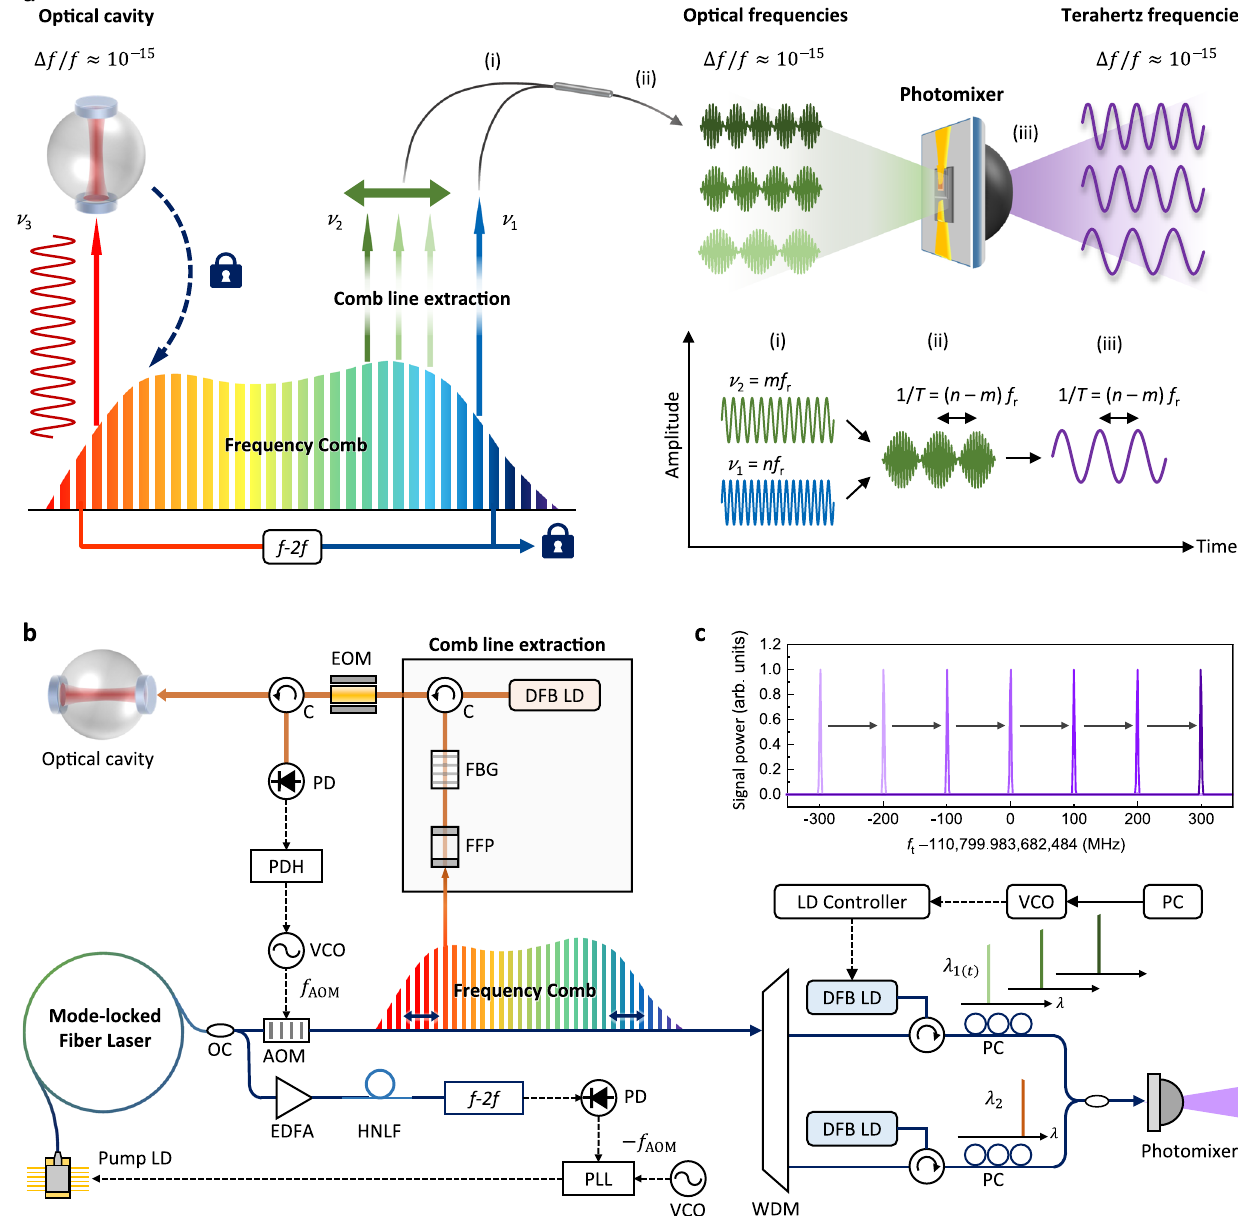
Fig. 1 | Comb-based generation of terahertz frequencies with reference to an opticalcavity.a Multiplepairsofopticalfrequenciesareextractedfromanoptical frequency comb (OFC) by means of injection locking to laser diodes (LDs). The extracted opticalfrequencypairsareconverted toterahertzfrequenciesthrougha photomixer, while the OFC is locked to a high- fi nesse cavity. f r : repetition rate, T: period. b Detailed scheme of comb-based terahertz synthesizer. c Terahertz